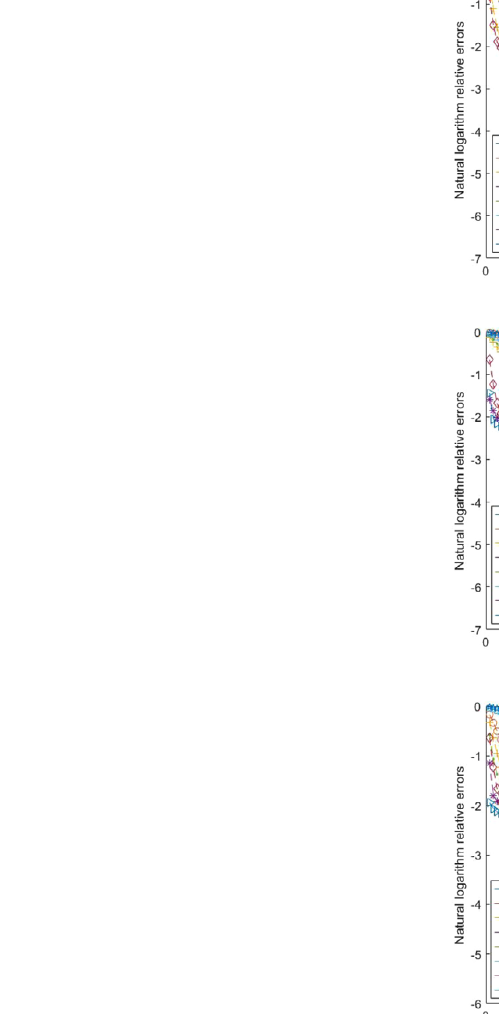
Figure 2 Natural logarithm relative errors for Example